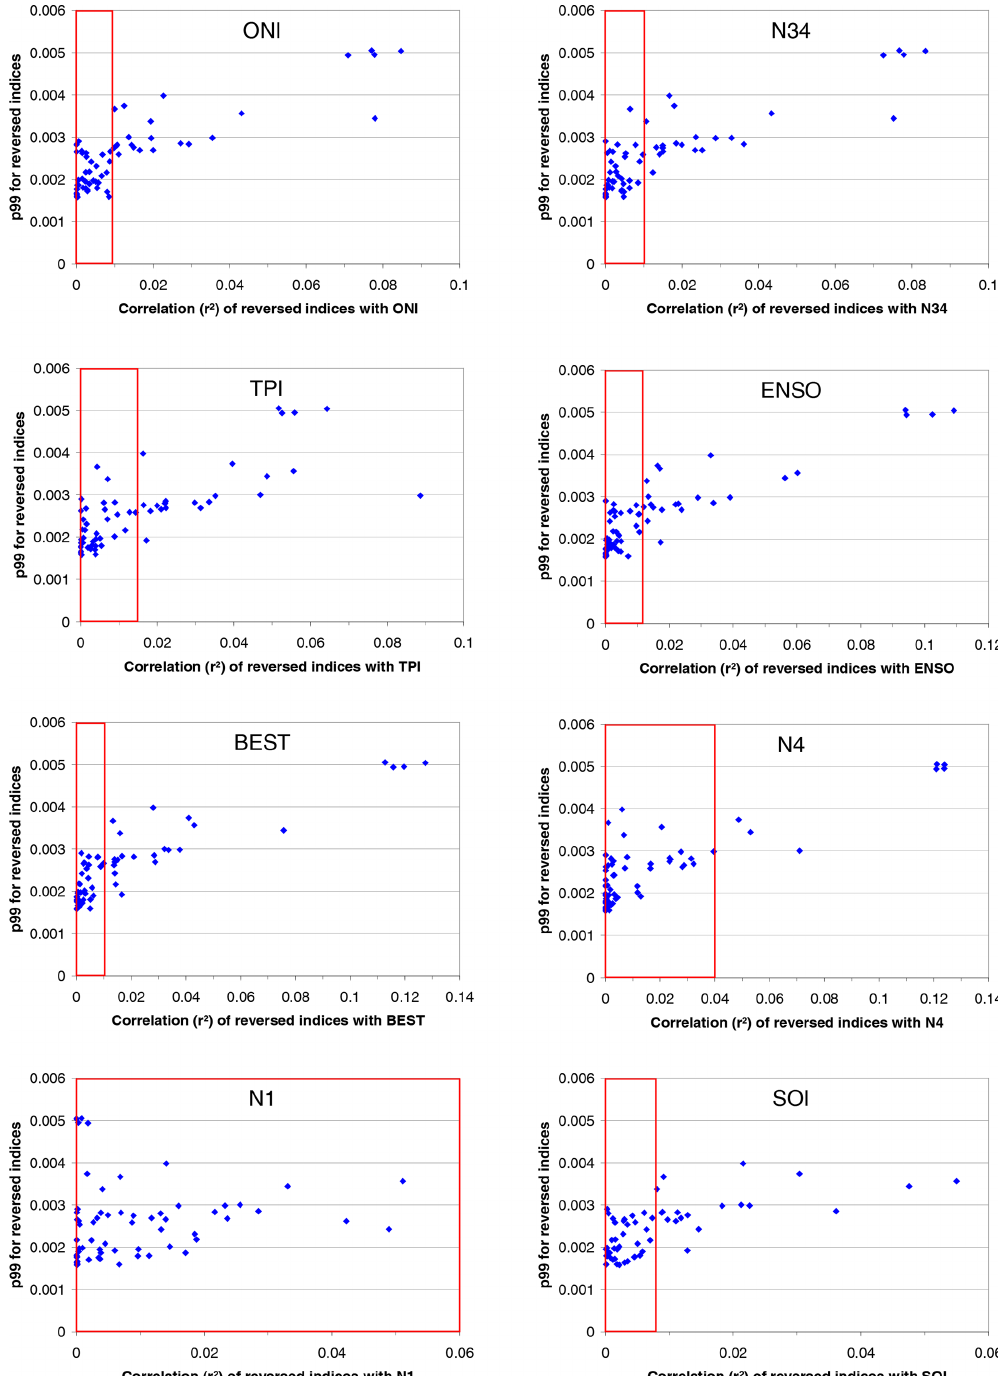
Figure A3. Correlation plots for the eight original indices with the highest p99 values. The blue dots represent the 61 reversed indices. The x axis describes the correlation coefficients of the reversed indices with the selected original indices. The y axis describes the p99 value or the reversed indices. High p99 values are found for the reversed indices which show high correlation to the original indices.